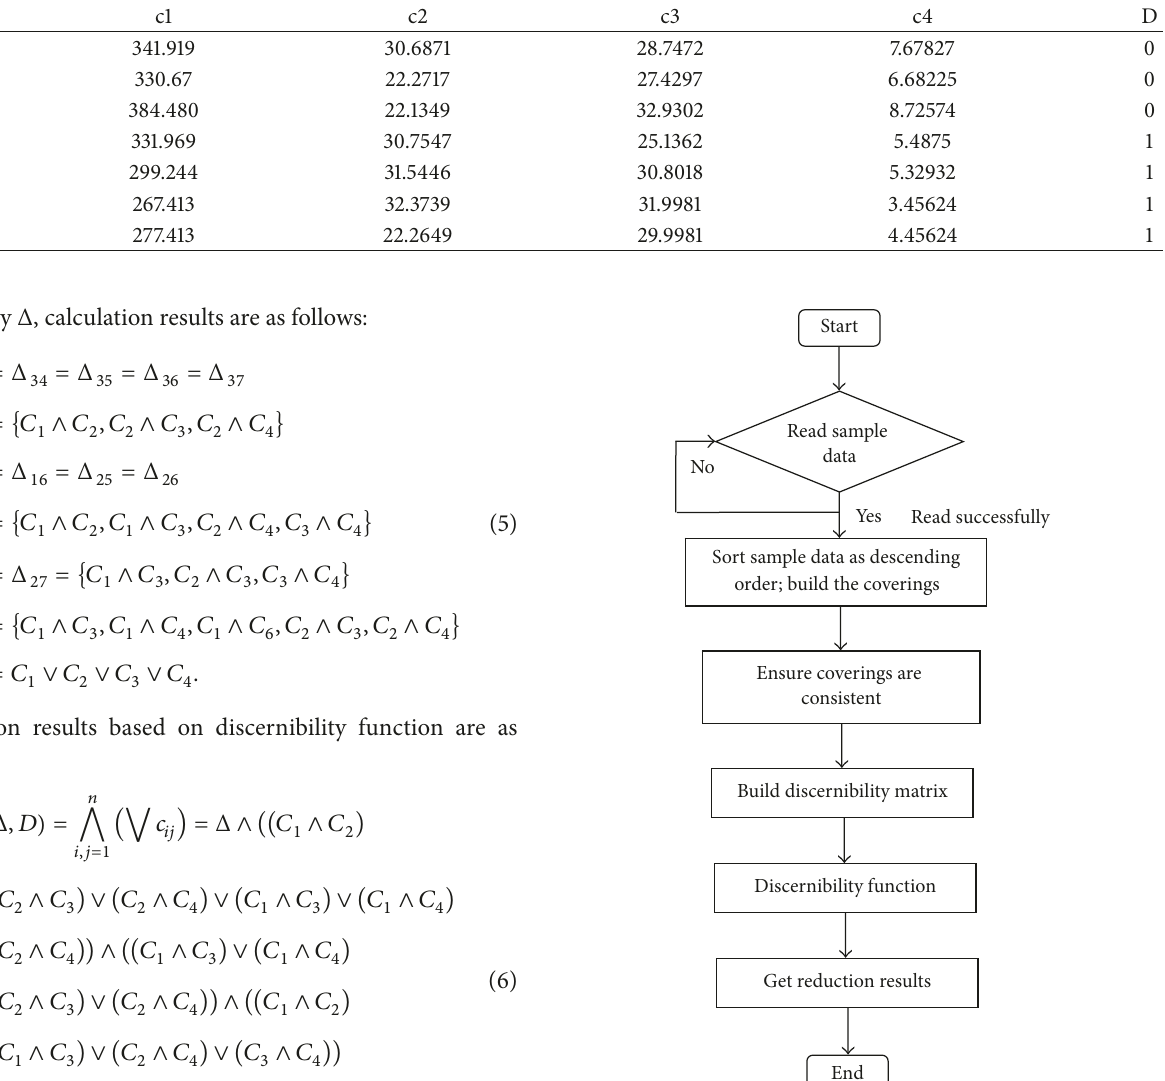
Table 4: Logging data set.